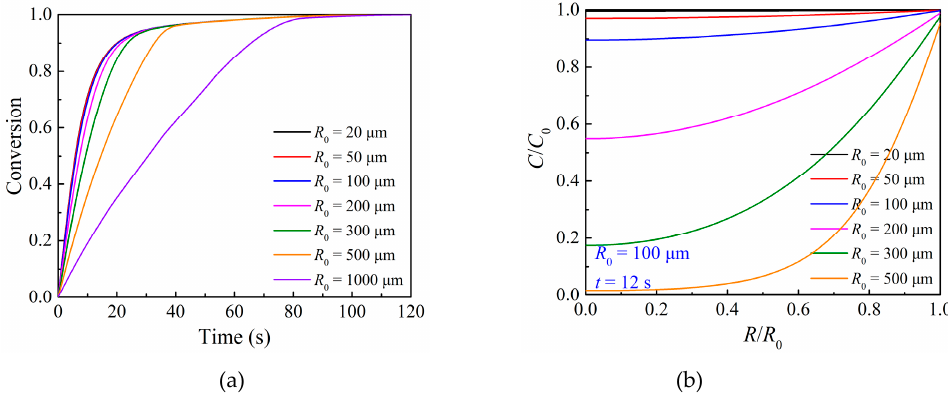
Figure 10. Effects of particle size on ( a ) the overall conversion of the particle and ( b ) oxygen concentration at R / R 0 = 0.5 during the oxidation reaction at 800 ◦ C.